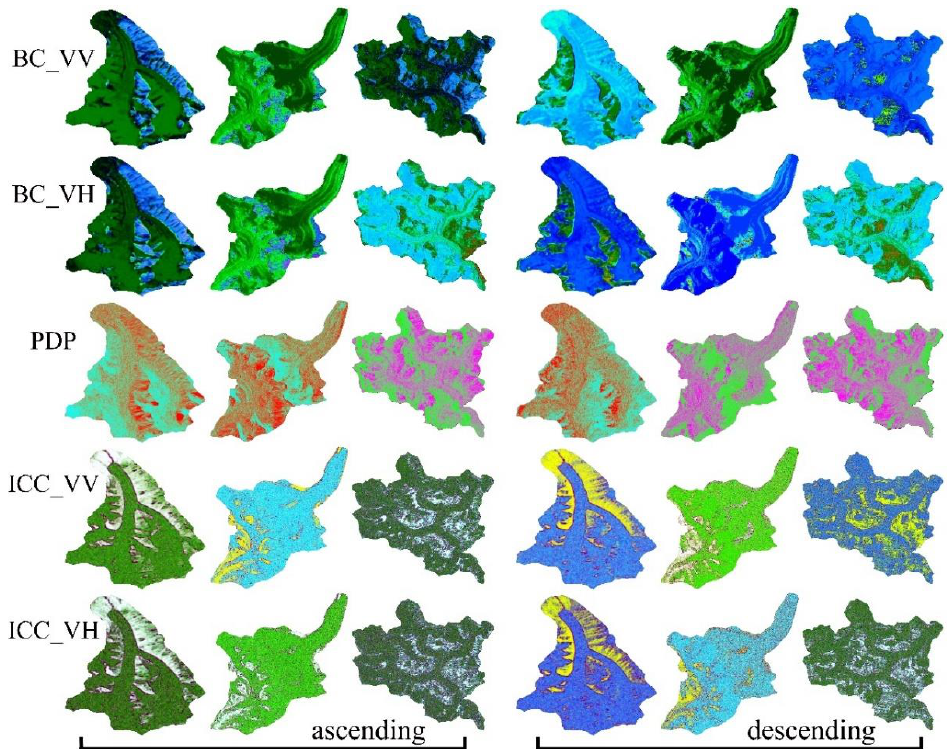
Figure 13. False-color images of four glaciers. R, G, B channels correspond to the first three important layers of each data suite: For the BC suite, RGB = elevation, sigma naught, and sigma naught-based texture_3; for the PDP suite, RGB = elevation, anisotropy, and entropy; for the ICC suite, RGB = elevation, coherence coefficient and texture_2 from the coherence coefficient. The left and right sides are four glaciers corresponding to the ascending and descending nodes, respectively. Each row represents the co-polarization and cross-polarization of three data suites from top to